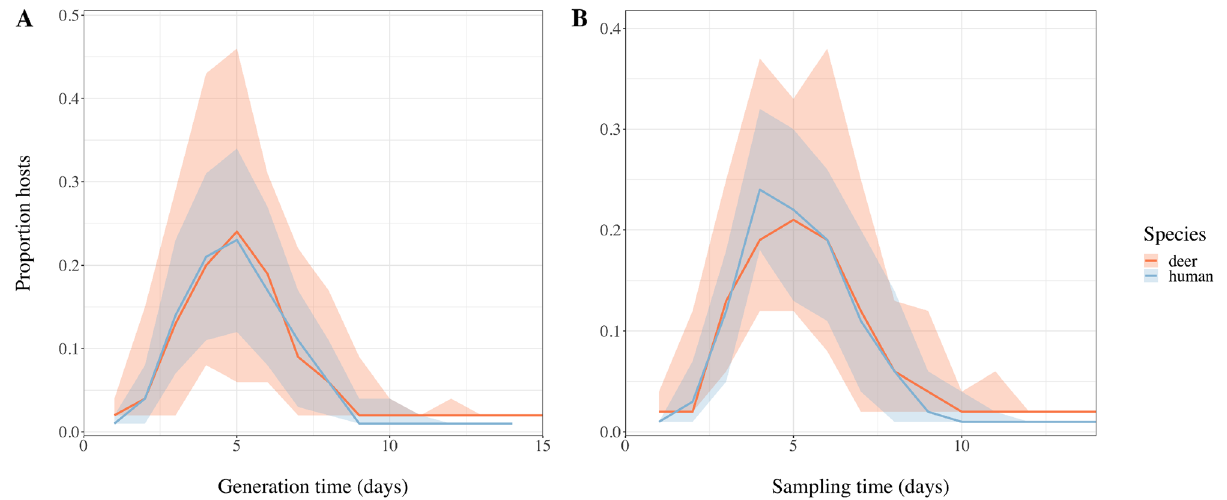
Figure 5. ( A ) Posterior median generation time of SARS-CoV-2 and ( B ) posterior median time between becoming infected with SARS-CoV-2 and being sampled with associated range (shaded area) for sampled deer (orange) and humans